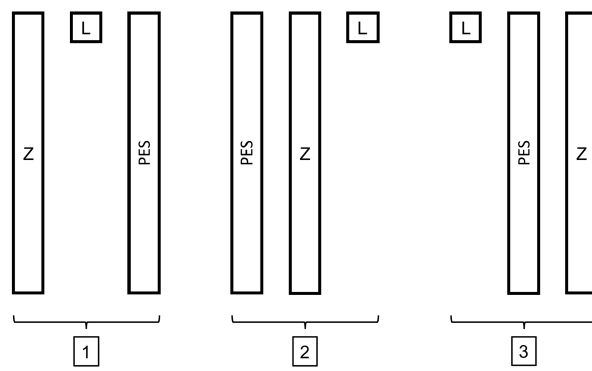
Figure 1. The three different templates. Z: Z technique, L: Levine’s technique and PES: pencil eraser swab technique. Each rectangle has the dimensions of 1cm × 10cm, the square measures 1cm × 1cm, and there is 1cm between each template.